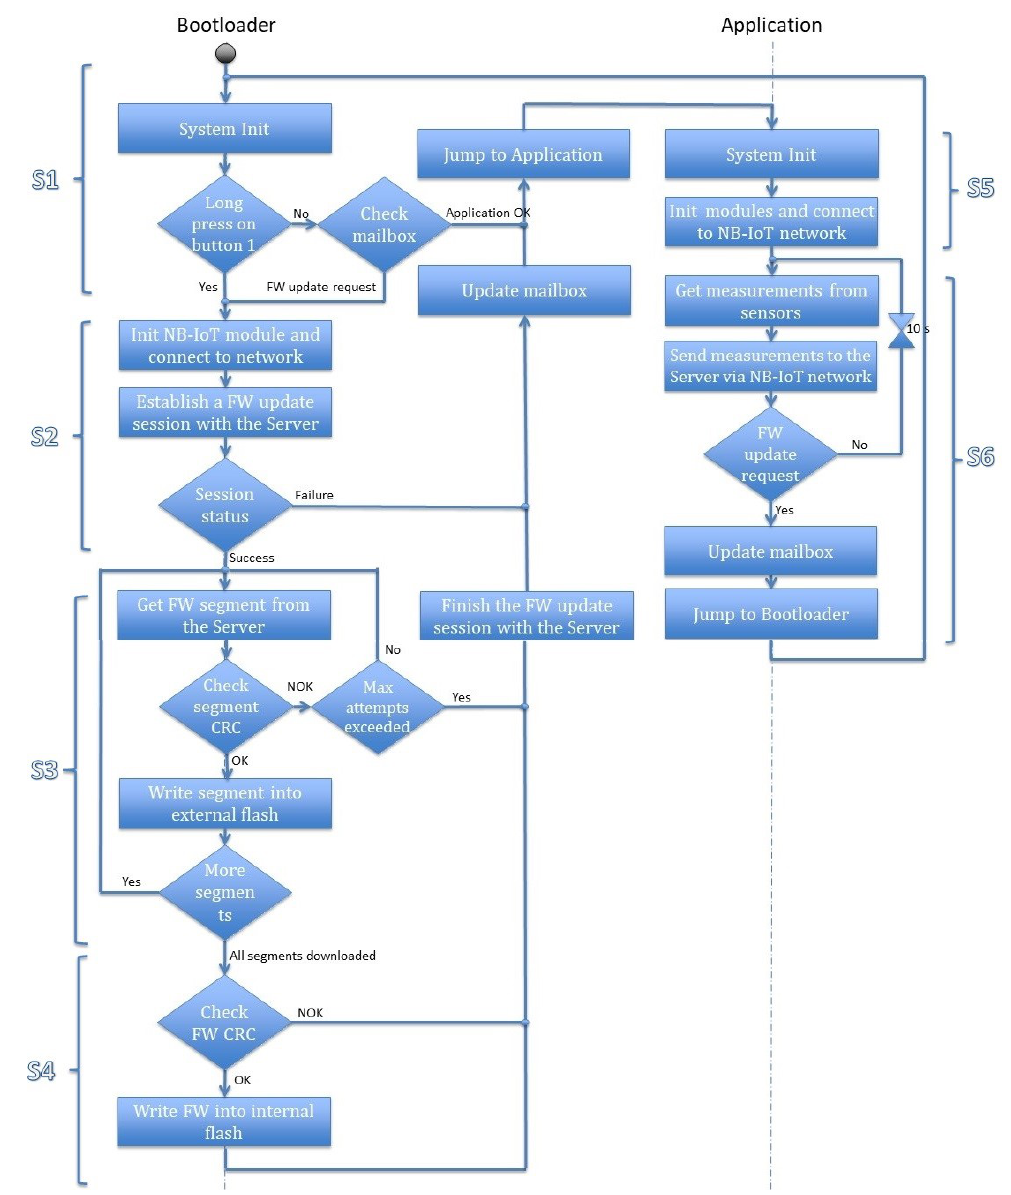
Figure 5. Firmware update